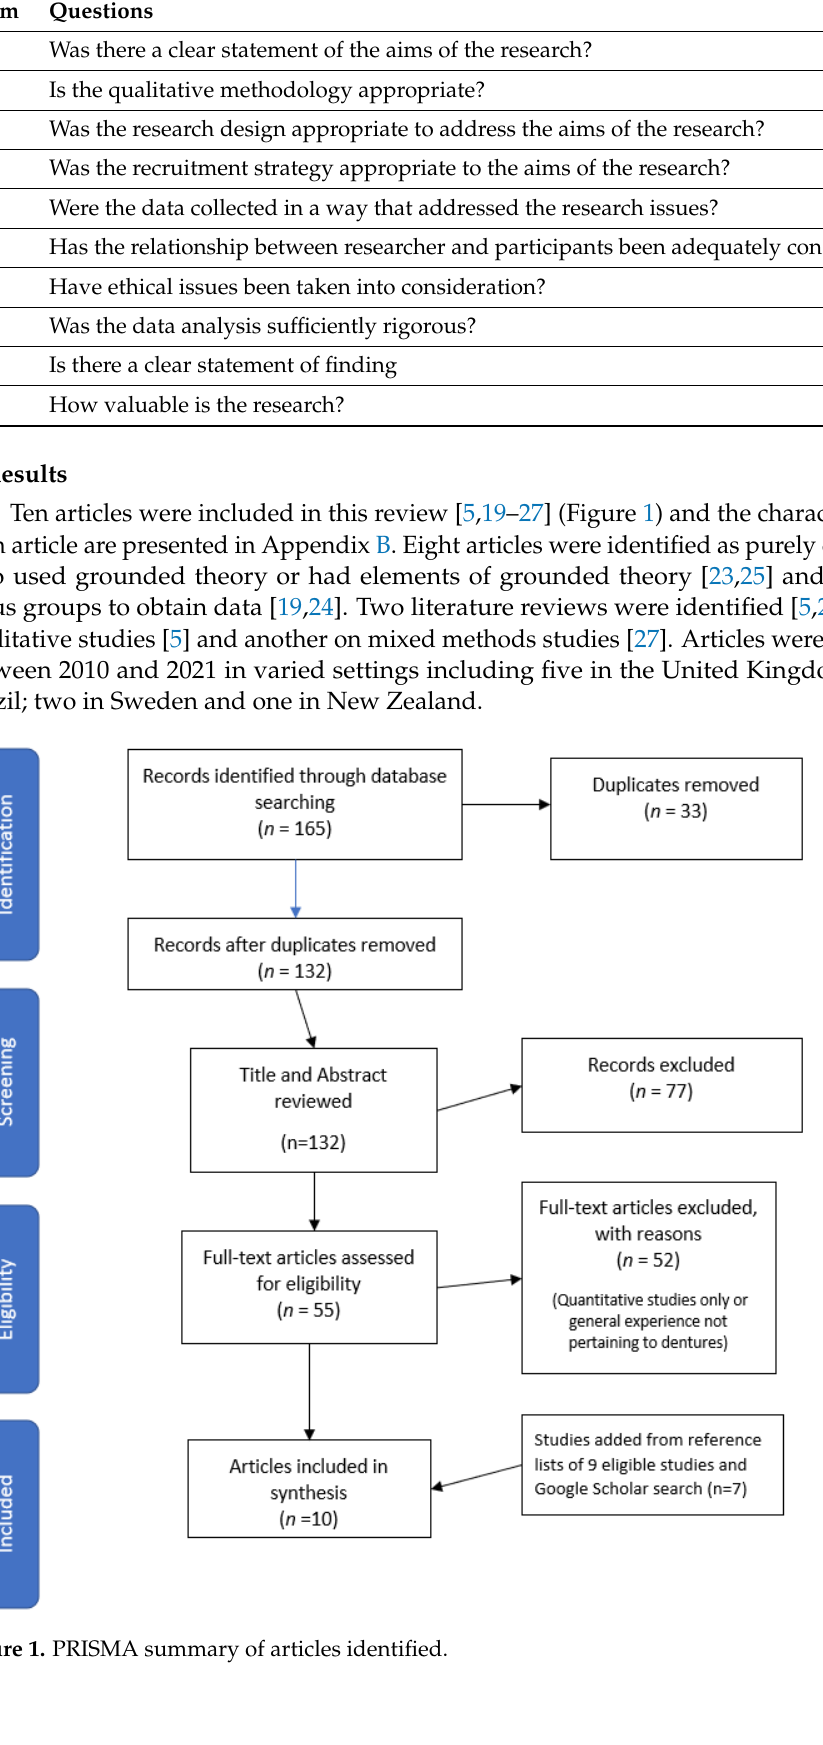
Table 2. Critical appraisal Skills Program Tool.